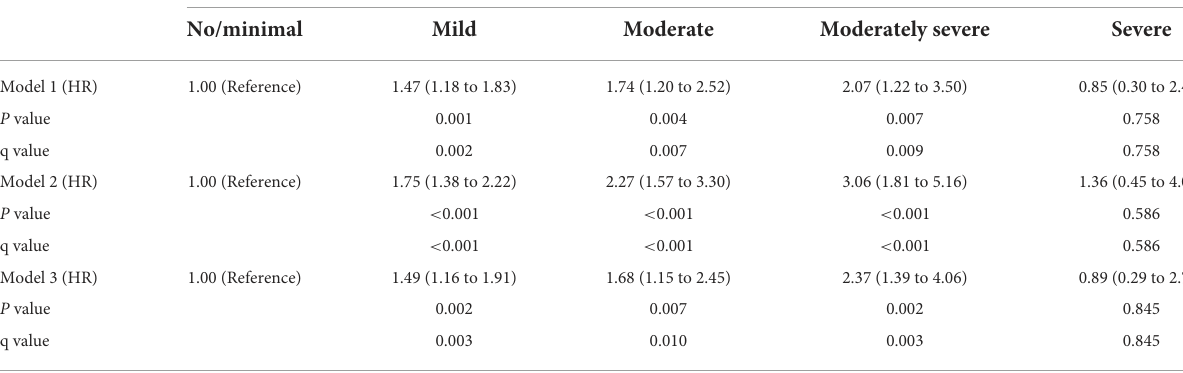
TABLE 5 Crude and adjusted association between depression level and cardiovascular mortality.